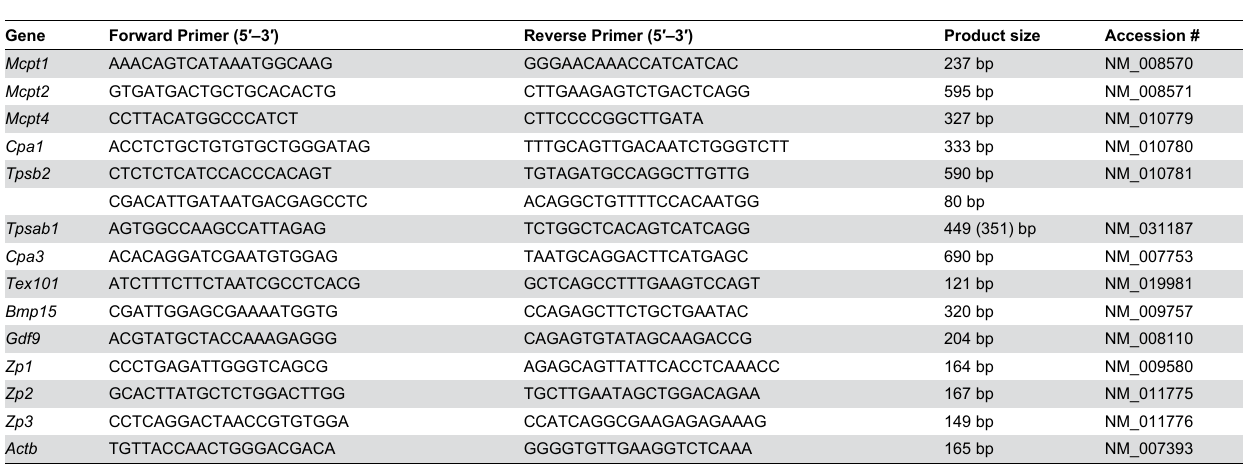
Table 1. Summary of the specific gene primers.